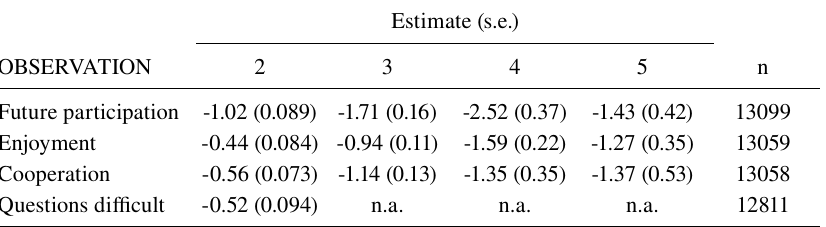
Estimates from logistic regressions for each observation Estimate OBSERVATION